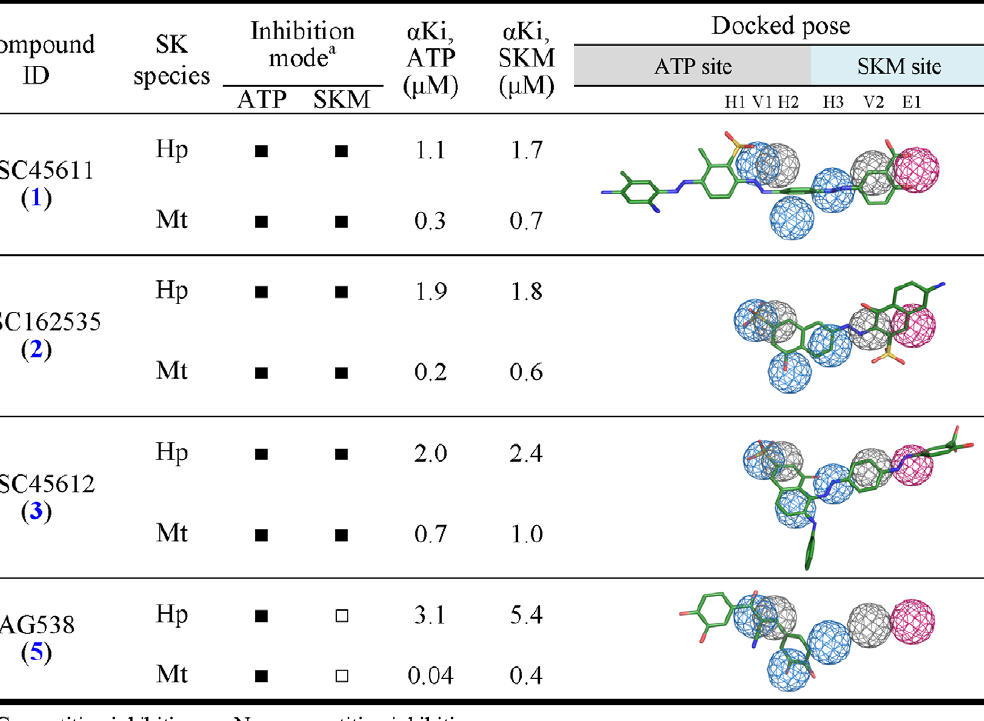
Figure 5. Properties of some potent inhibitors of HpSK and MtSK. Docked poses of NSC45611, NSC162535, and NSC45612 are located at the ATP site (H1, H2, and V1) and the shikimate site (H3, V2, and E1), and these inhibitors are competitive inhibitors of ATP and shikimate (SKM). AG538 is a competitive inhibitor of ATP, in agreement with its docked pose.